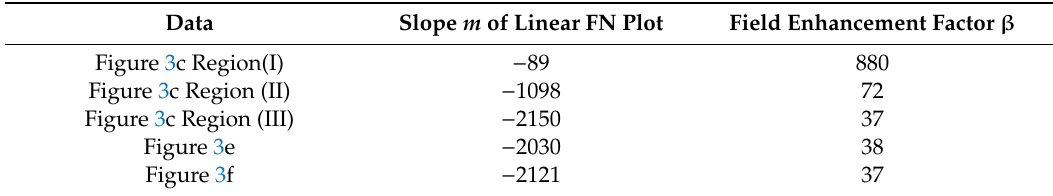
Table 1. Summary of FE parameters for curves of Figure 3.